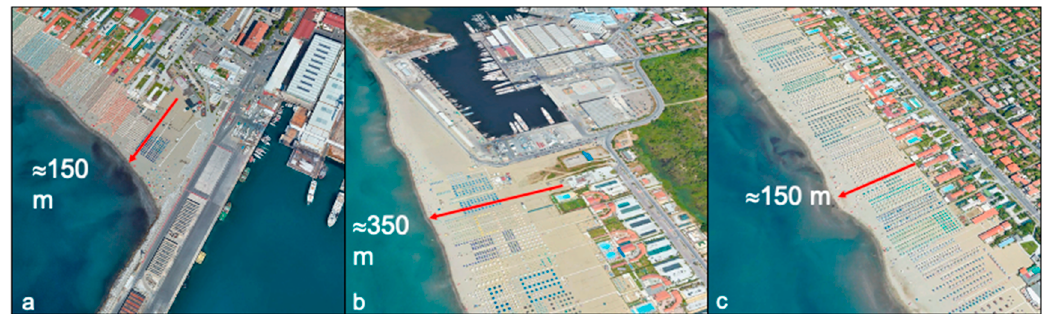
Figure 10. Aerial views of three hotspots along the Northern Tuscany littoral cell with the indication of beach width. ( a ) updrift beach at the Port of Marina di Carrara; ( b ) updrift beach at the Port of Viareggio; ( c ) the convergence area at Marina di Pietrasanta. The images were retrieved from the GoogleEarth database.